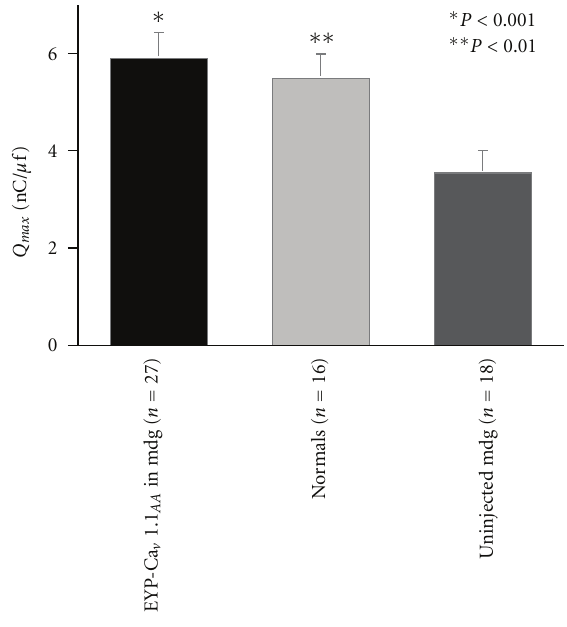
Figure 4: Ca v 1.1 AA generates normal densities of intramembrane charge movement. The average maximal, immobilization-resistant charge movement at +40 mV ( Q max ) obtained from the indicated number of myotubes for each group. The charge movements were elicited by 25 ms depolarizations from a pedestal potential ( − 50mV) to +40 mV. Symbols and error bars represent mean ±